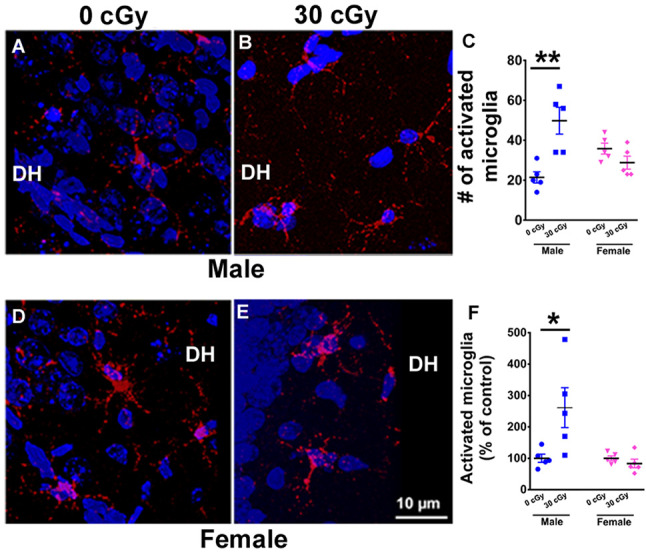
Microglial activation in mice 15 weeks following 4He ion irradiation. Representative confocal images showing activated microglia (CD68+, red) in the counterstained (blue) Dentate Hilus (DH) of the hippocampus for male (A,B) and female (D,E) mice. Two-way ANOVA demonstrated a significant interaction between irradiation and sex (p = 0.001), a significant radiation effect (p = 0.02), but no sex effect (p = 0.44). Post hoc analysis revealed a 2.5-fold increase in the number of activated microglia when compared to same-sex controls (p = 0.001, C). Female mice showed no change in the number activated microglia (p = 0.99, C). A similar two-way ANOVA on the percentage of activated microglia showed a significant interaction between irradiation and sex (p = 0.02), a significant radiation effect (p = 0.04), and a significant sex effect (p = 0.02). Post hoc analysis showed a significant increase in the percentage of activated microglia in the hippocampus of irradiated male mice when compared to same-sex controls (p = 0.02, F). Female mice showed no such change (p = 0.99, F). Percentages shown reflect values normalized to the average of all unirradiated controls, arbitrarily set to 100%. Data are expressed as the mean ± SEM, N = 5 for each experimental group. *p < 0.05, **p < 0.01 vs. unirradiated males.